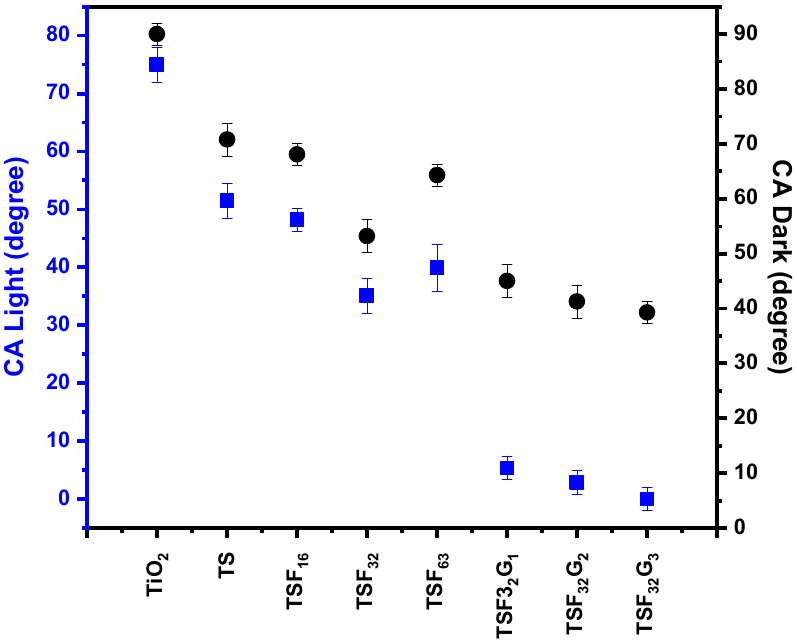
Figure 9. Water contact angle (CA) images of the coated films on the titanium substrate in the dark and under illumination.